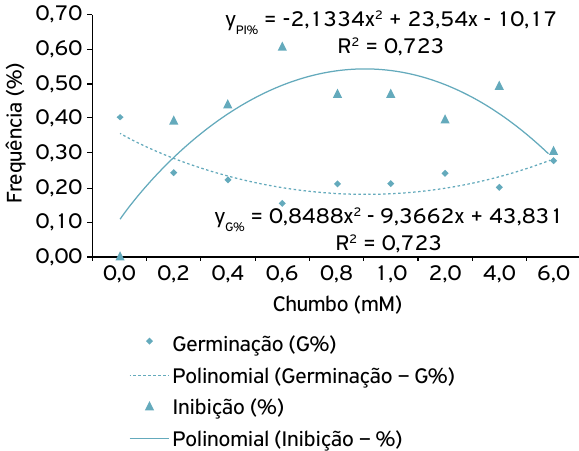
Figura 4. Percentual de germinação e potencial inibitório do chumbo em sementes de Schinus terebinthifolius .